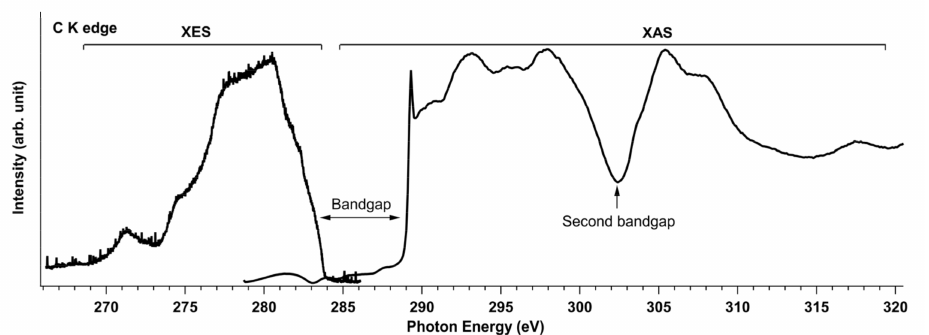
Figure 1. Total electron yield-X-ray absorption spectroscopy (TEY-XAS) (right) and X-ray emission spectroscopy (XES) (left) at the C K-edge of undoped single crystal diamond (uSCD). The diamond bandgaps are